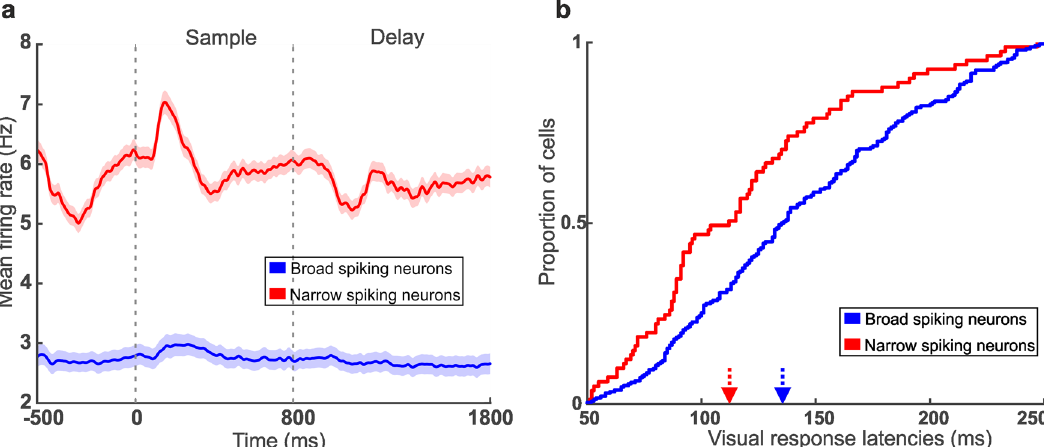
Fig. 3 Basic physiological differences of NS and BS. a Mean fi ring rates during trial phases for NS (red) and BS (blue) neurons. b Cumulative histogram for response latencies. Arrows indicate median latencies for NS (red) and BS (blue)